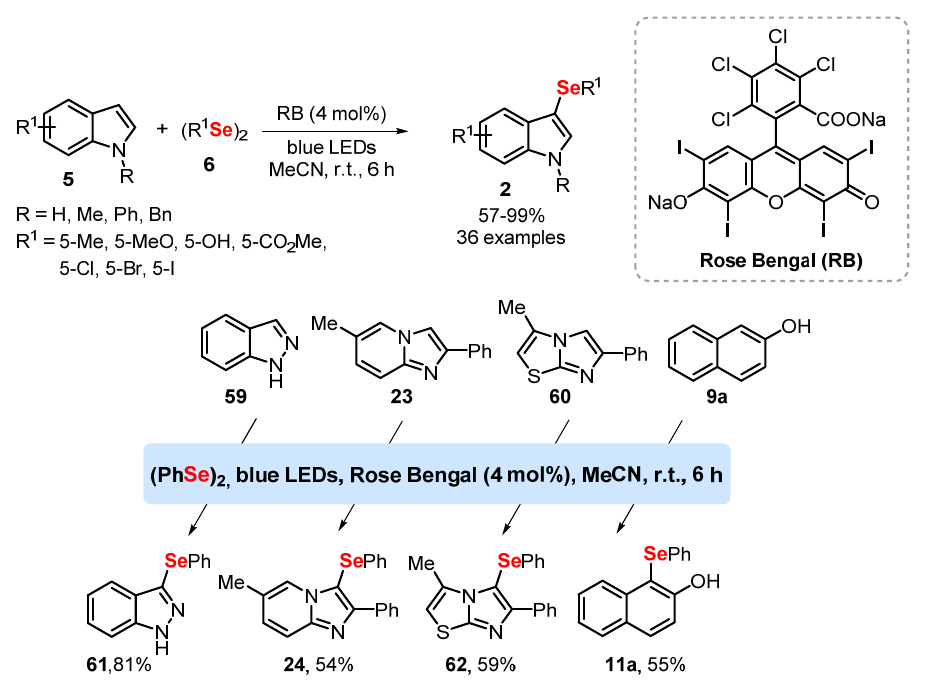
Molecules 2022 , 27 , x FOR PEER